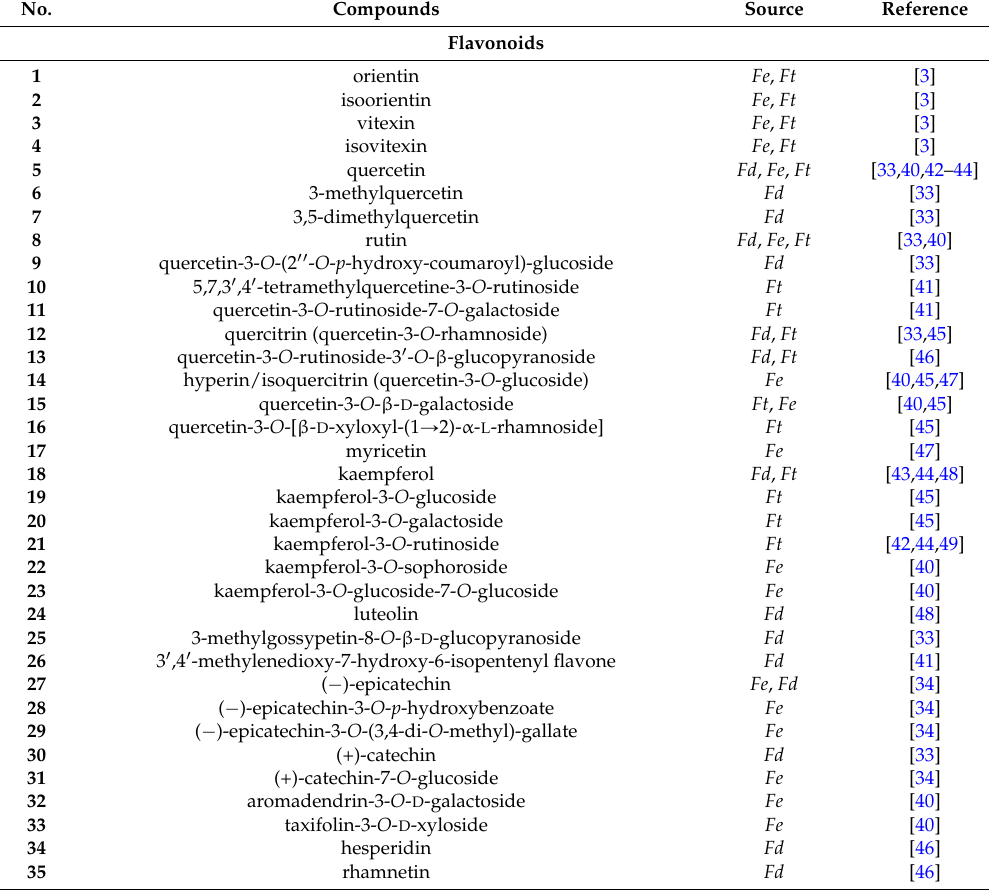
Table 1. Chemical constitutents from Fagopyrum esculentum ( F. esculentum ), Fagopyrum tataricum ( F. tataricum ) and Fagopyrum dibotrys ( F. dibotrys